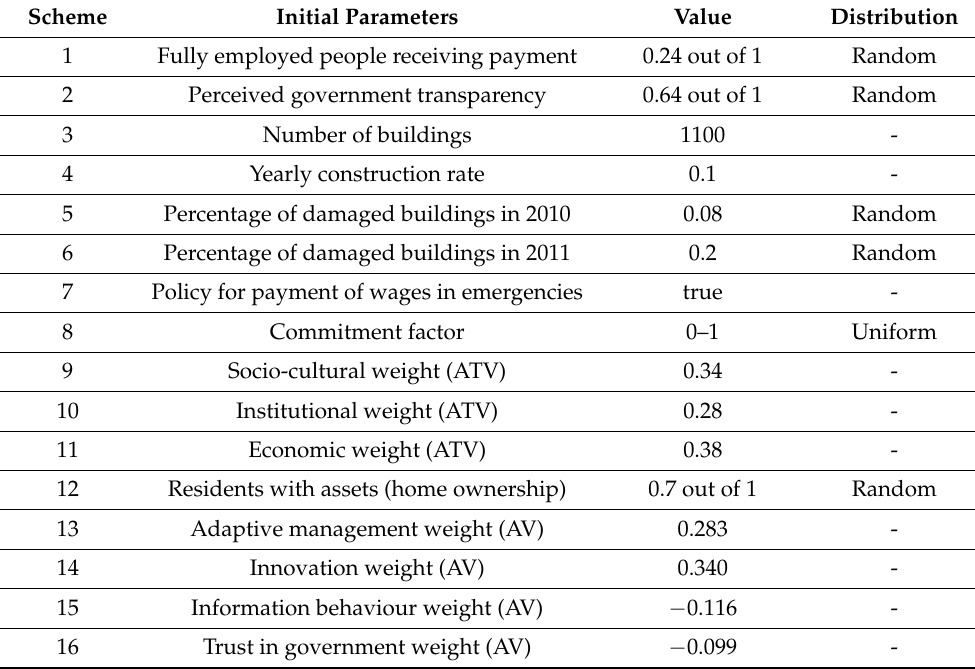
Table 1. Values for the base model